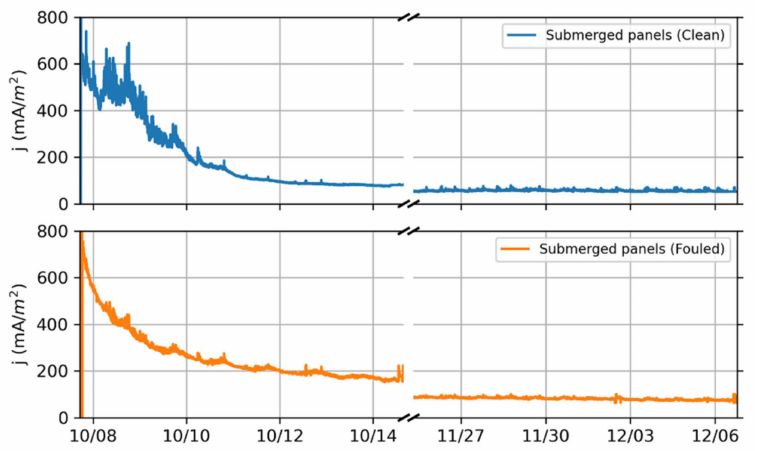
Figure 8. Current densities of constantly submerged panels: Clean ( top ) and previously fouled and corroded ( bottom